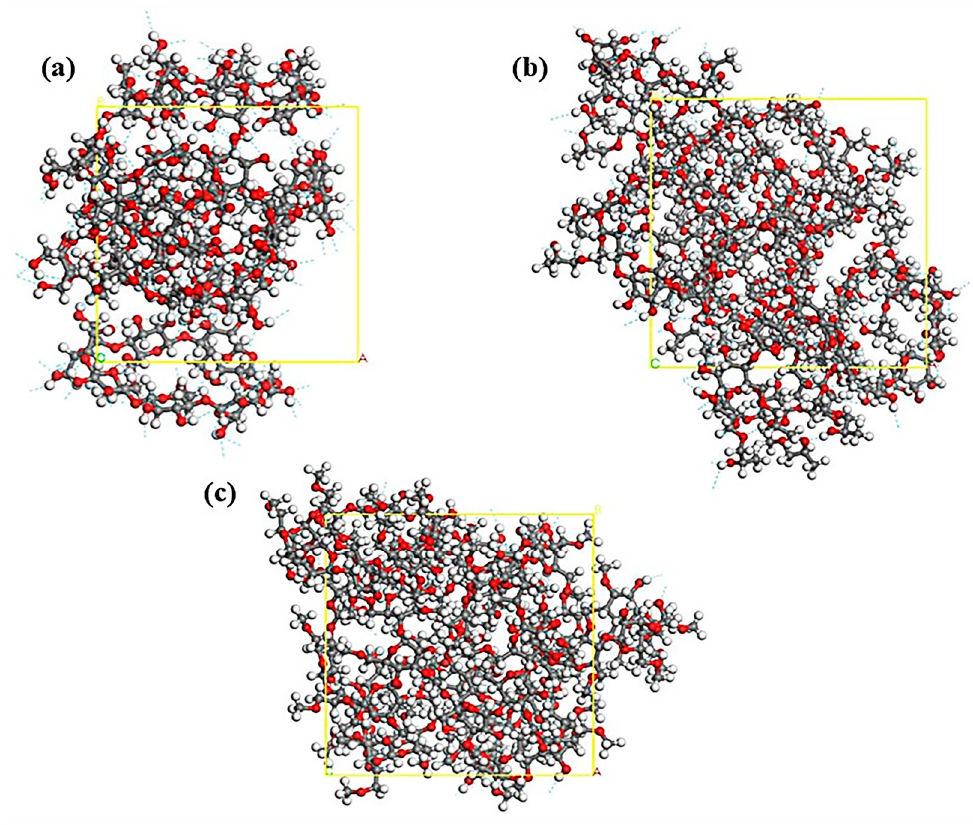
Figure 12. Models for MD simulation of ( a ) β -CD system, ( b ) HP- β -CD system, ( c ) DM- β -CD system (the white atom represents H, the gray atom represents C, the red atom represents O and the blue dashed line represents hydrogen bonds, the yellow squares represent the cells).